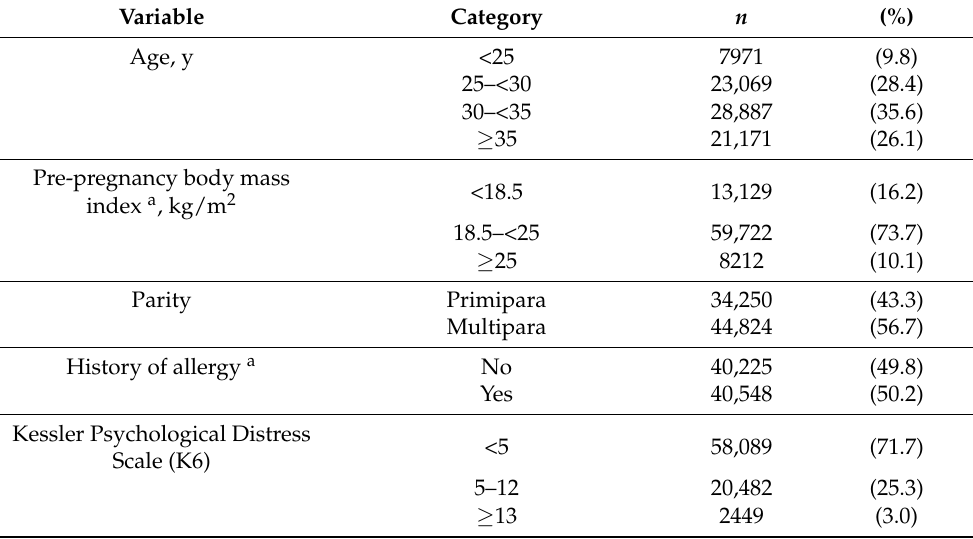
Table 1. Characteristics of mothers and dwelling